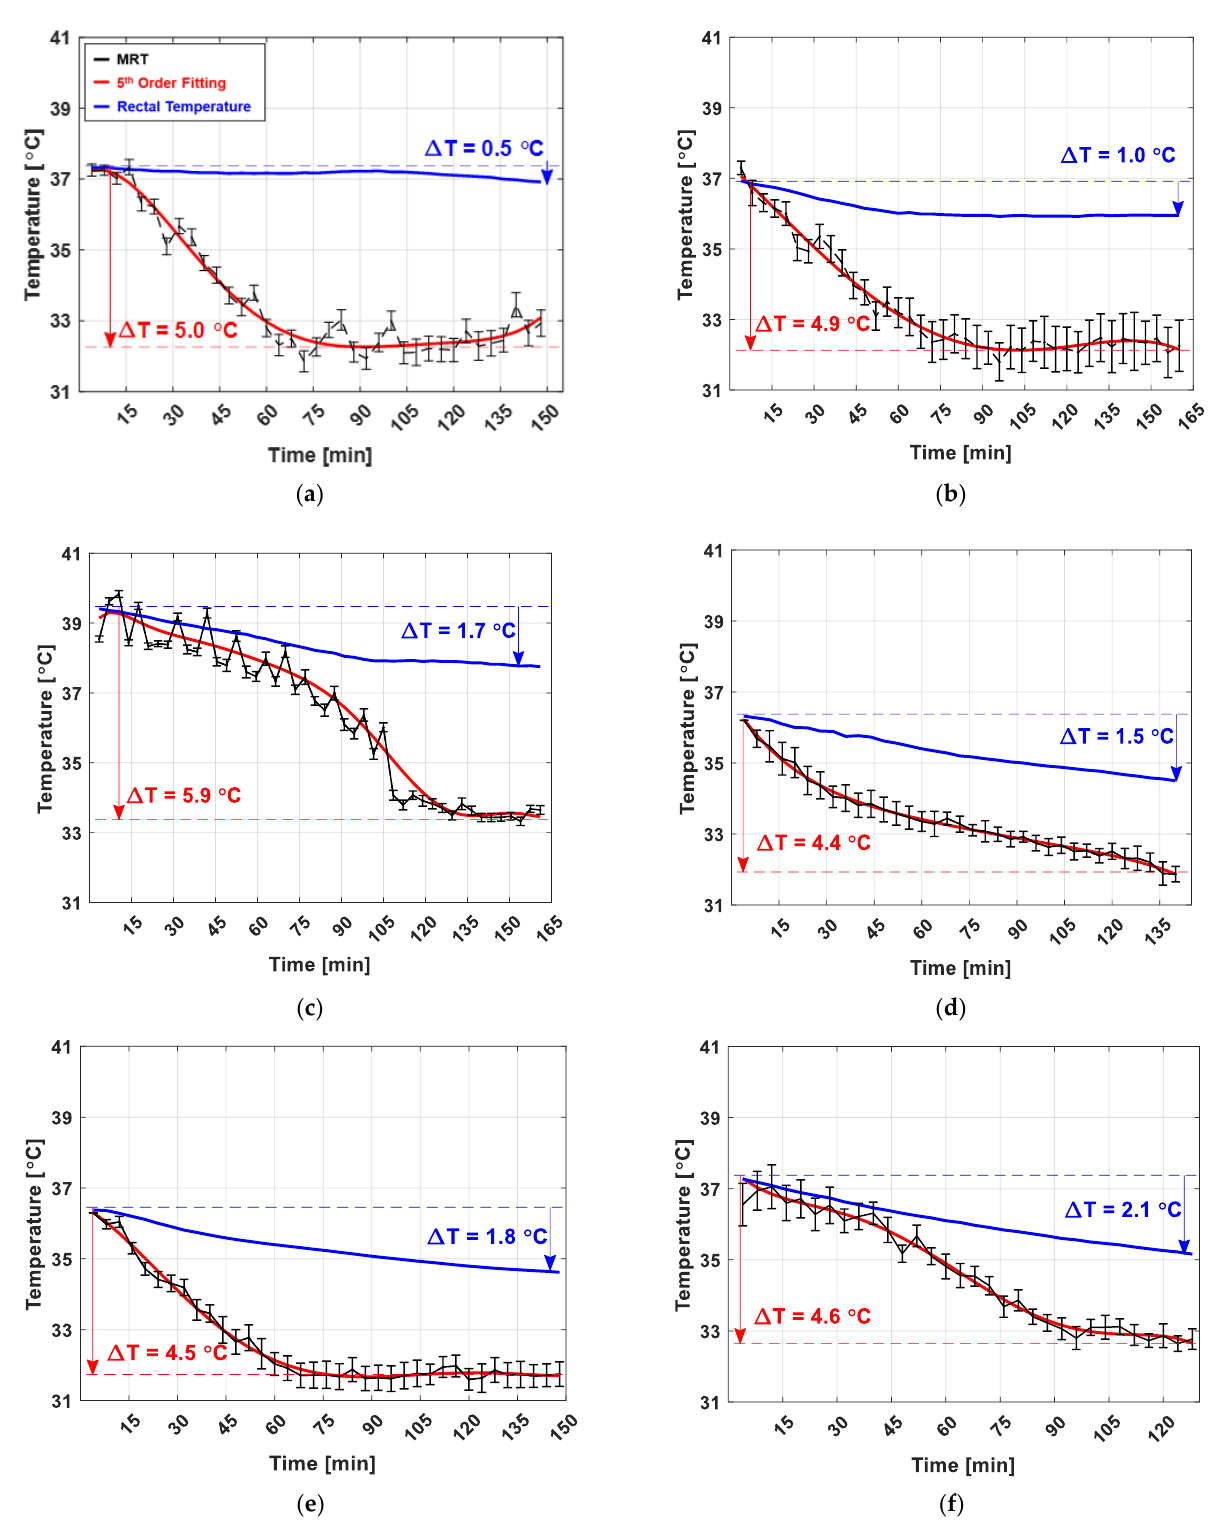
Figure 6. Temperature changes in the white and gray matters of six canines under general anesthesia. Mean temperature changes in white matter (corpus callosum, red line, 4.8 ± 0.5 °C) and gray matter (cerebral cortex, blue line, 2.6 ± 0.9 °C) of six canines under general anesthesia. The error bars indicate the standard deviation in the temperature changes of the six subjects. ( a , b ) depict the results for overweight canines (BCS 8); ( c – e ) depict those for canines of normal weight (BCS 4 – 5); and ( f ) depicts the result of underweight canines (BCS 2).